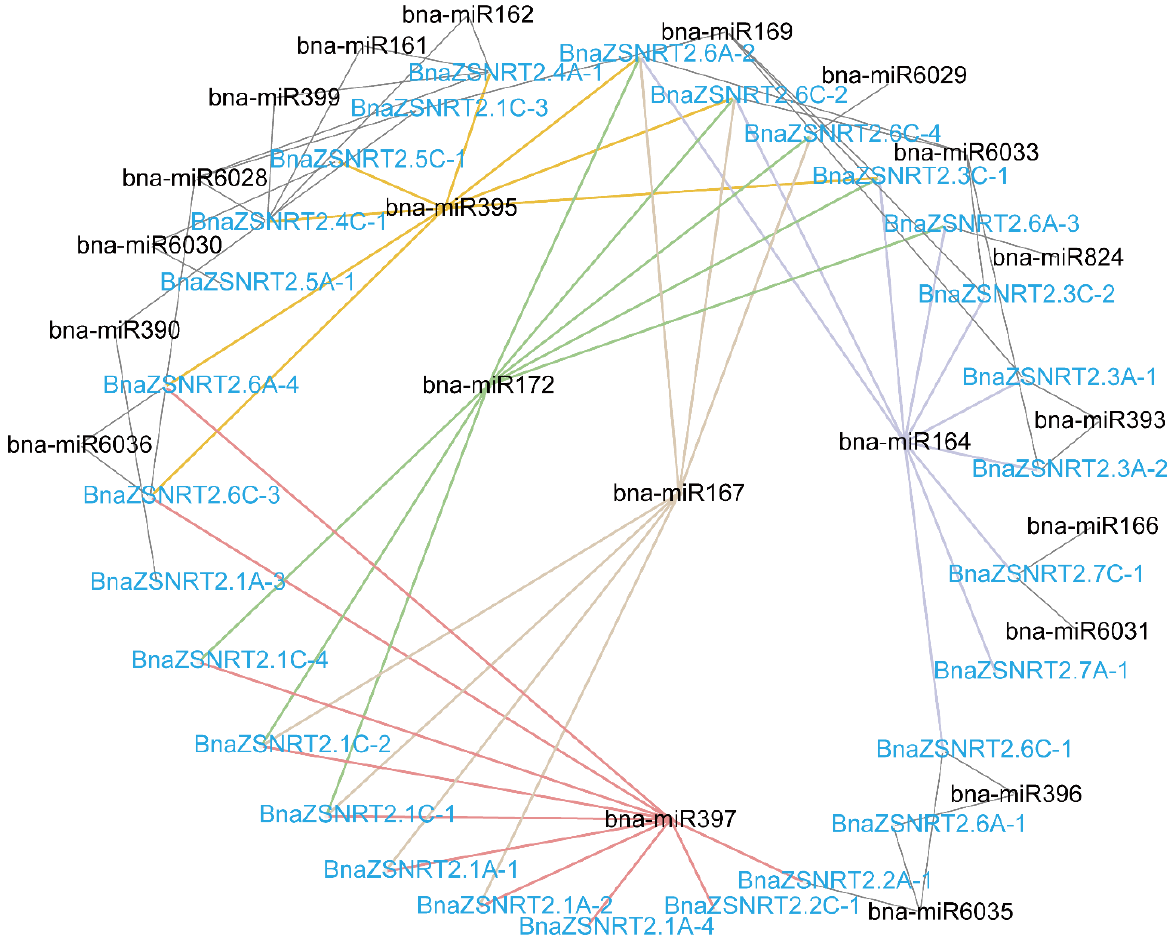
Figure 4. The potential miRNA targeting network of the BnaZSNRT2s . A total of 21 miRNAs with black were predicted. BnaZSNRT2s were represented in blue.